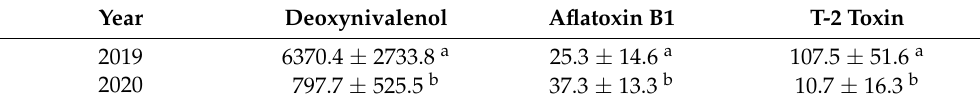
Table 4. Mycotoxin levels ( µ g/kg of dry matter) according to the year of harvest.